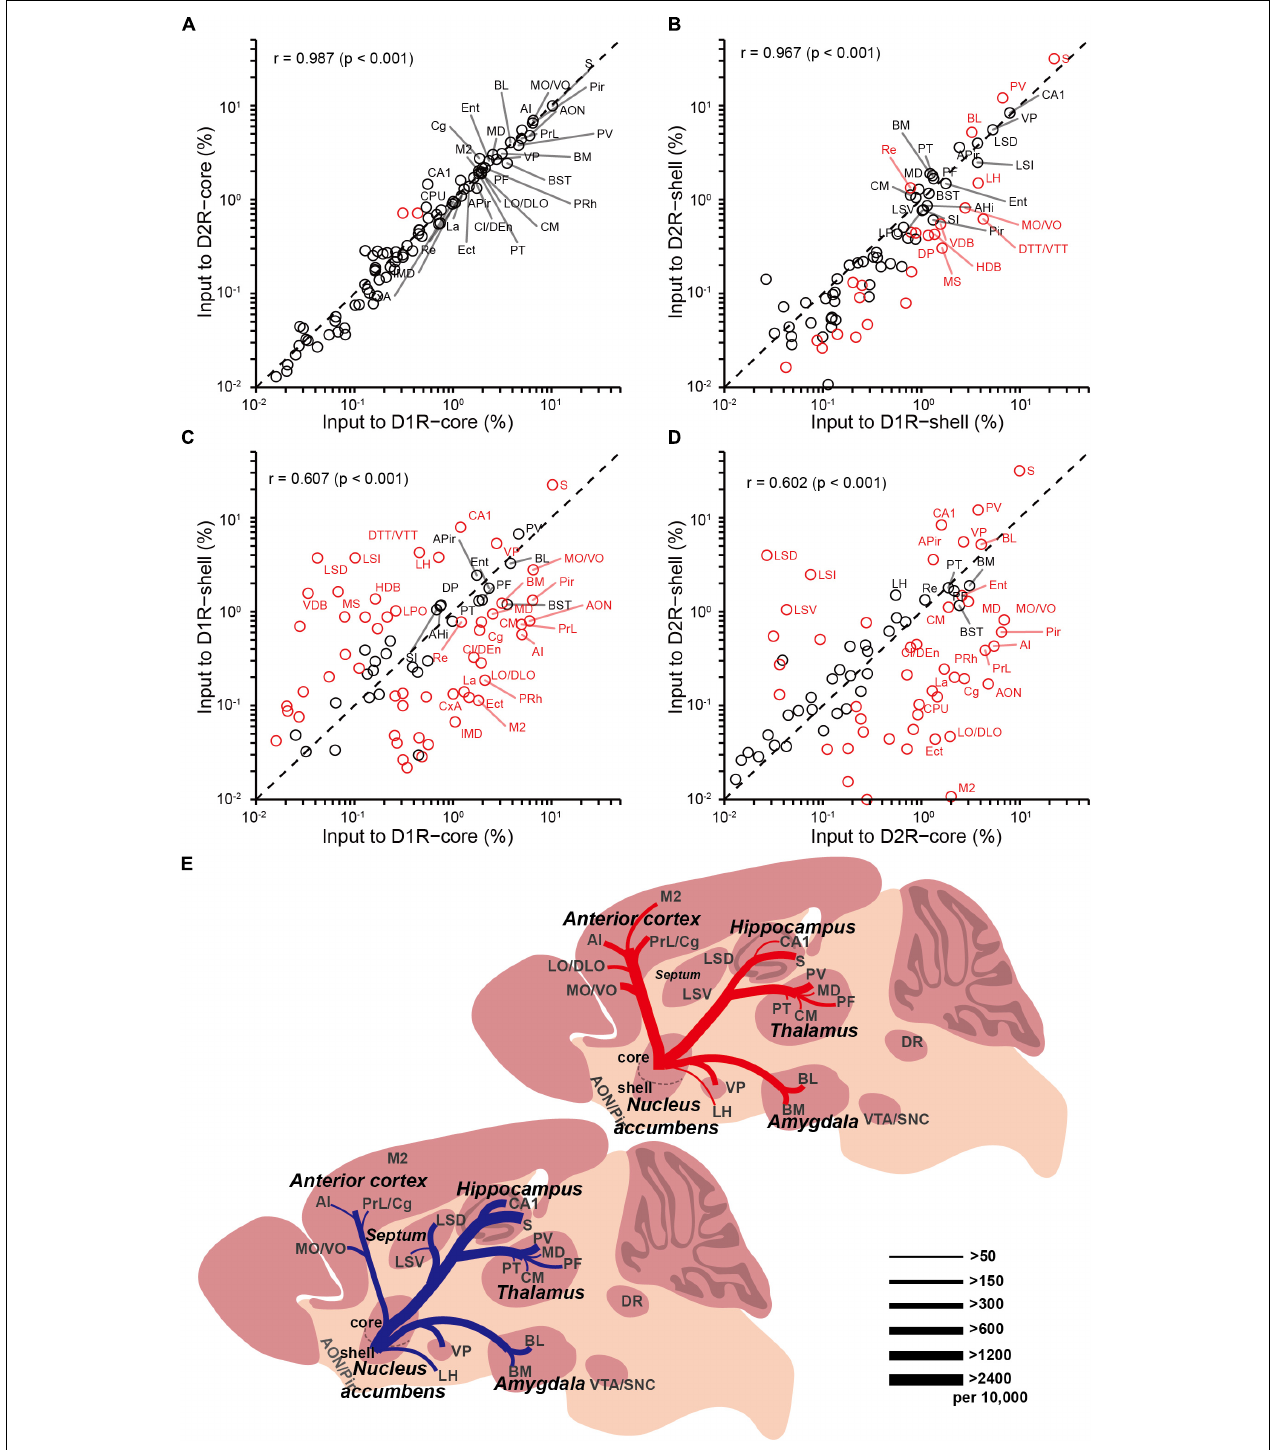
FIGURE 7 | Comparisons of input distributions across the four groups. (A) Comparison between inputs to D1R-core and D2R-core neurons. (B) Comparison between inputs to D1R-shell and D2R-shell neurons. (C) Comparison between inputs to D1R-core and D1R-shell neurons. (D) Comparison between inputs to D2R-core and D2R-shell neurons. Values are the means of the percent of total inputs from each region. Red circles indicate significant differences ( p < 0.05, two-tailed unpaired t -test or Mann–Whitney U test). r , Pearson’s correlation coefficient. (E) Summary of selected prominent monosynaptic inputs to the NAc core (top, red) and shell (bottom, blue), considering D1R-MSNs and D2R-MSNs together. Line thickness represents the number of